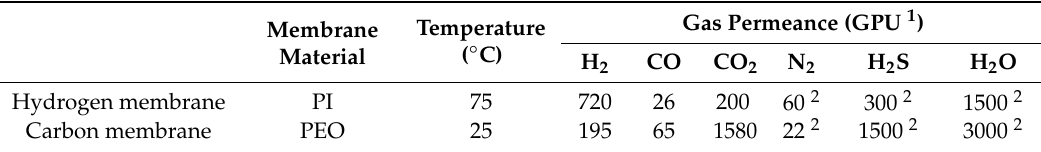
Table 1. Membrane permeance [32].